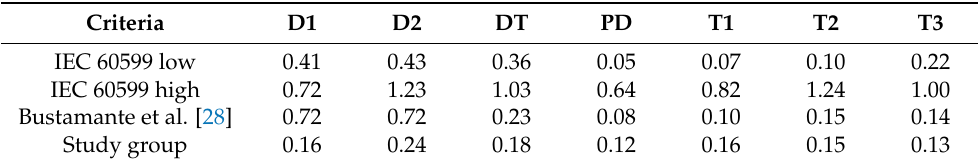
Table 7. The calculated increases in health index score for faults determined by the Duval Triangle 1 for 90th percentile gas